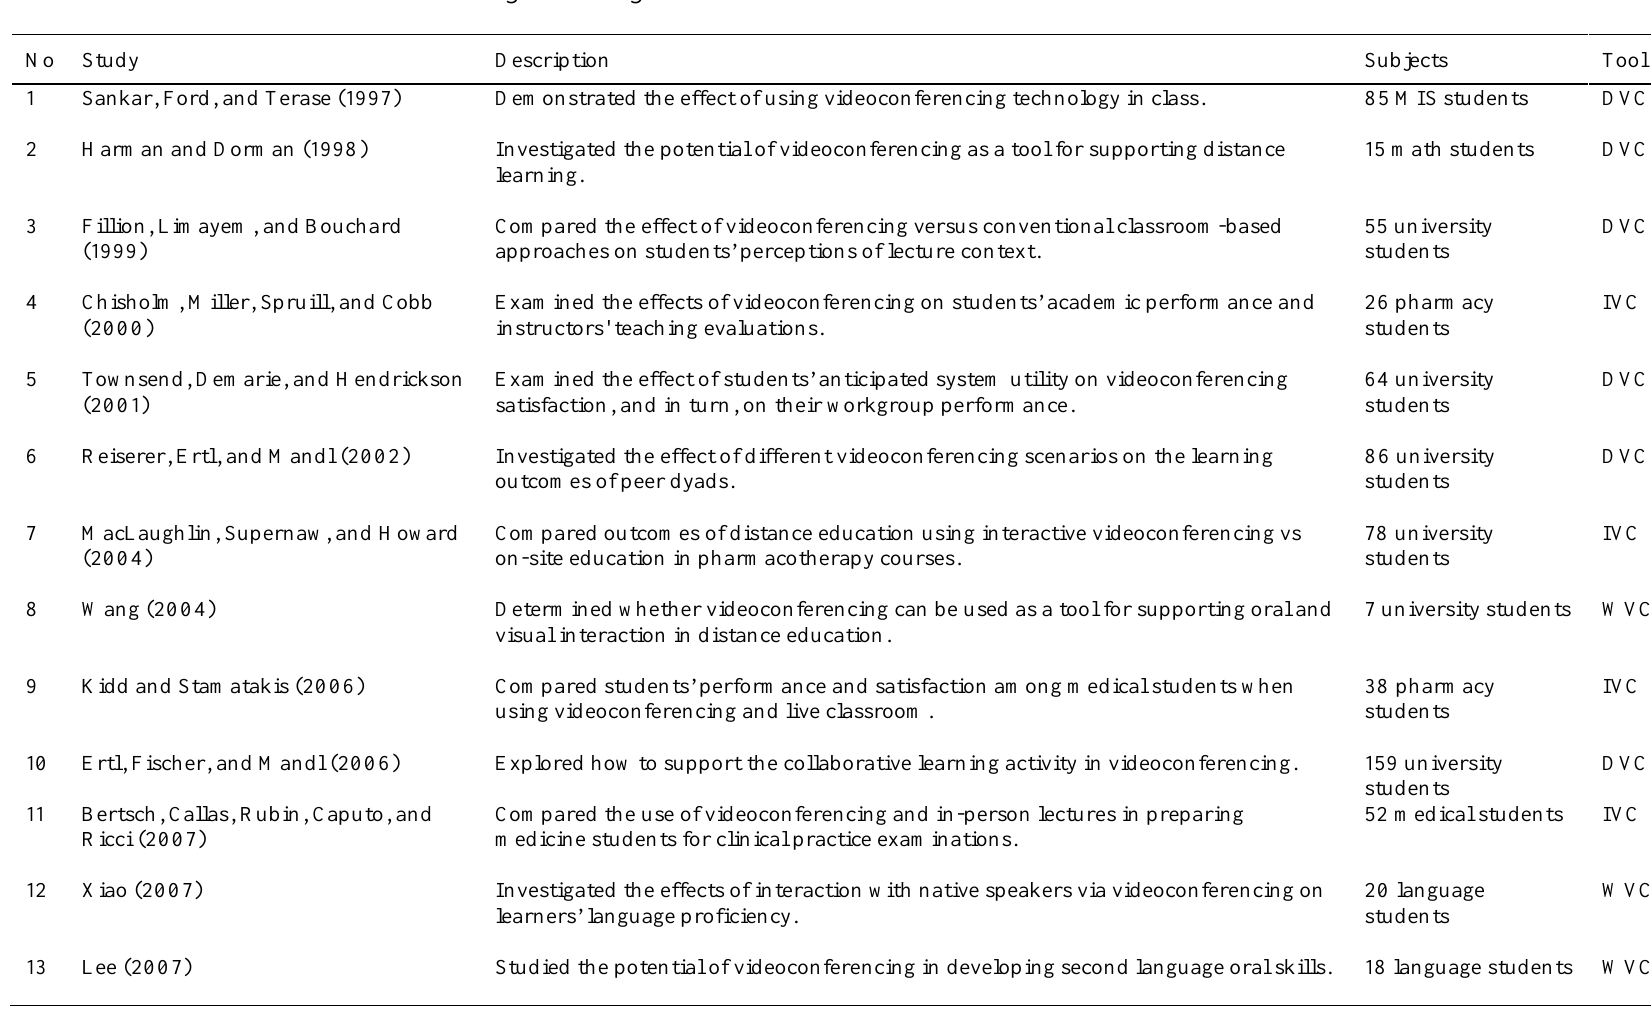
A Review of Studies About Videoconferencing Use in Higher